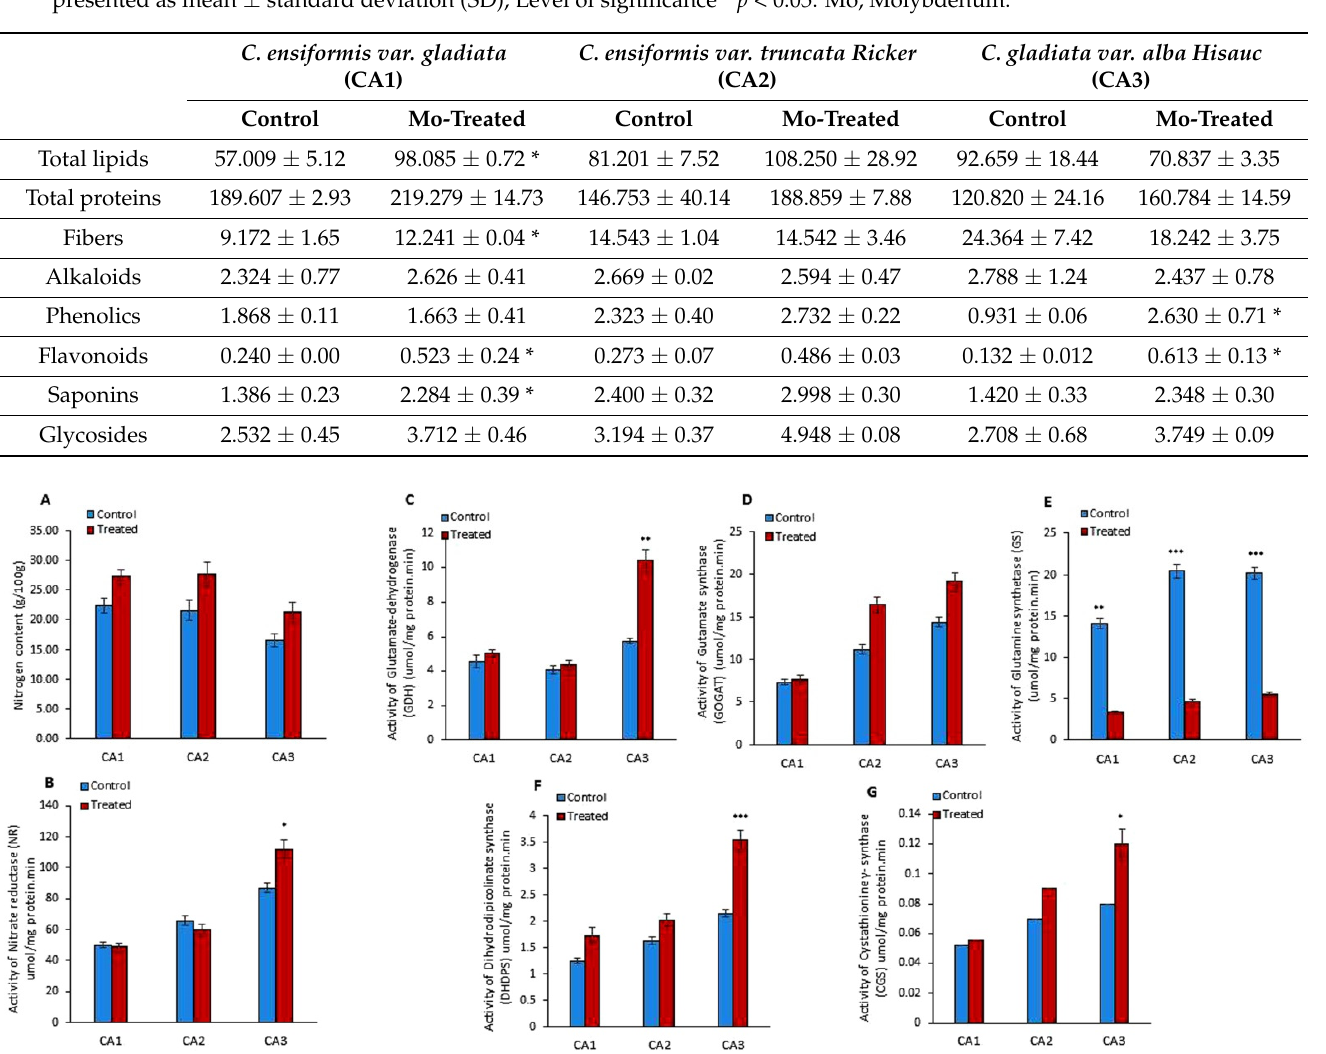
Table 1. Effect of molybdenum treatment on the nutritional value of Canavalia species/cultivar sprouts. Total lipids ( µ g/gFW), total proteins ( µ g/gFW), fibers ( µ g/gFW), alkaloids ( µ g/gFW), phenolics ( µ g/gFW), flavanoids ( µ g/gFW), saponins ( µ g/gFW), and glycosides ( µ g/gFW) were measured. Experiments were executed in triplicate and the data are presented as mean ± standard deviation (SD); Level of significance * p < 0.05. Mo, Molybdenum.